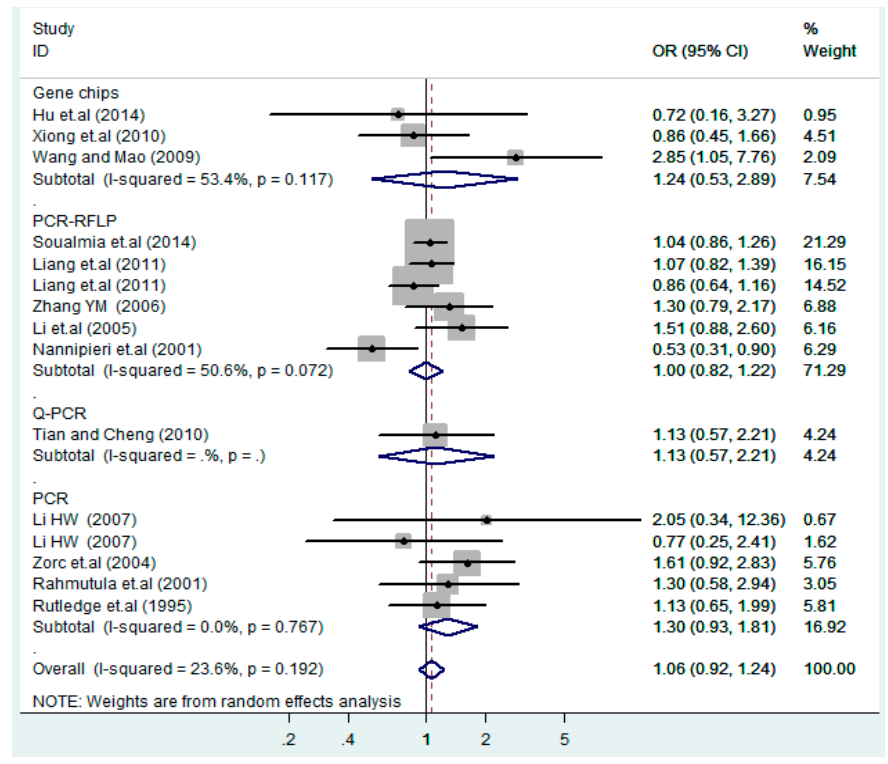
Figure 19. Subgroups of genotyping methods of T2238C additive model (C vs. T). Int. J. Environ. Res. Public Health 2016 , 13 , 458